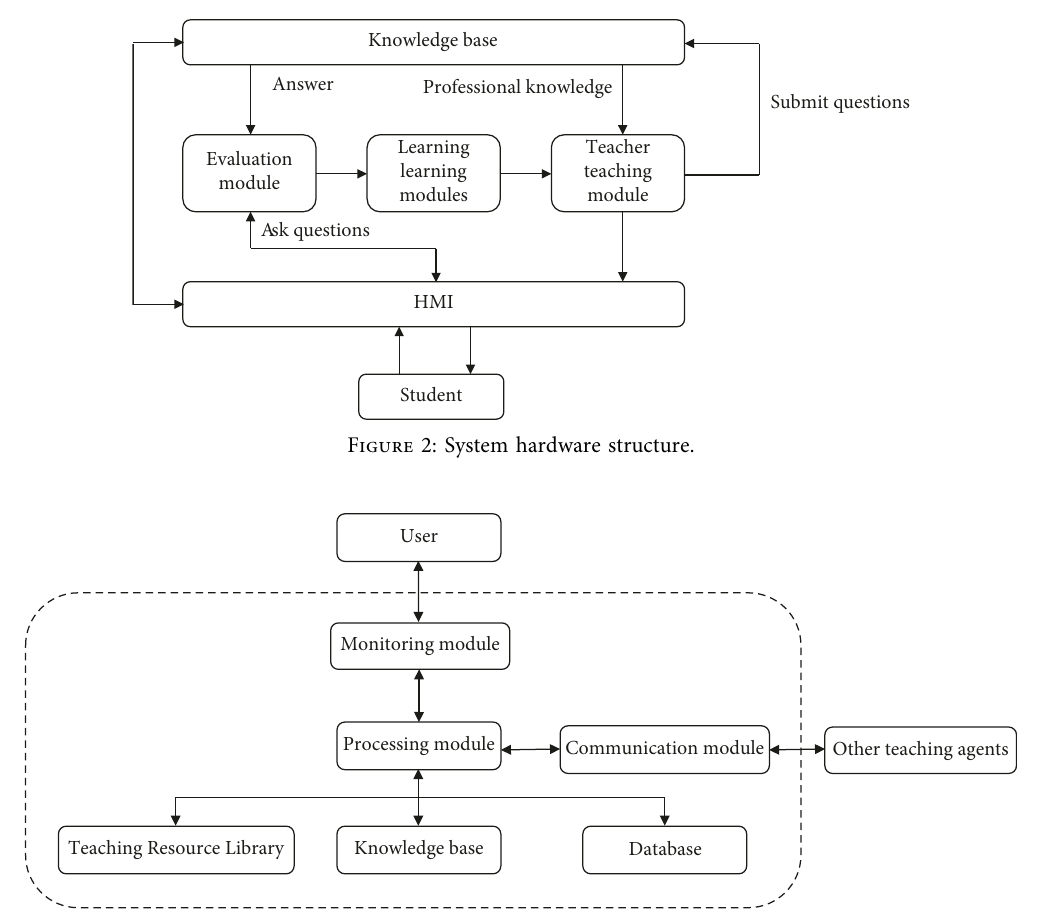
Figure 3: Student learning